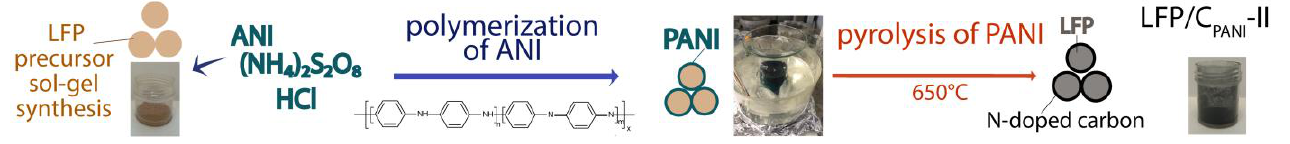
Figure 1. The schema of the LFP/C PANI -II formation.